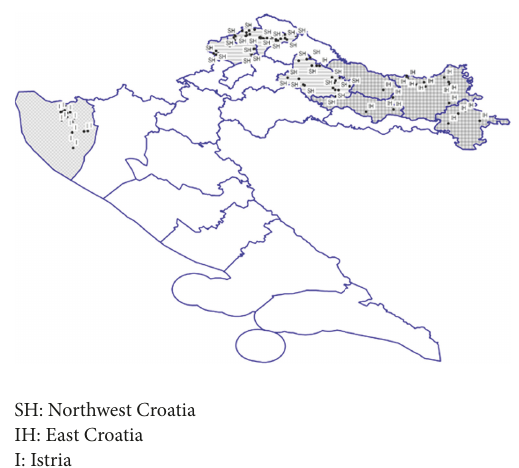
Figure 1: Diagram of the Republic of Croatia with three regions (East Croatia, Northwest Croatia, and Istria) and locations of acacia honey and soil